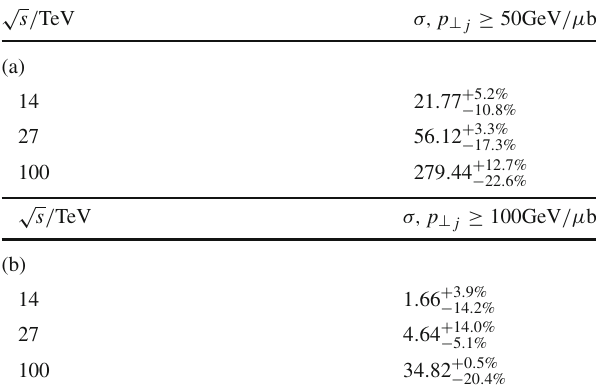
Table 8 Table showing (a) the total number of charged tracks inside | η | = 6, and (b) the average transverse momentum of charged tracks, as